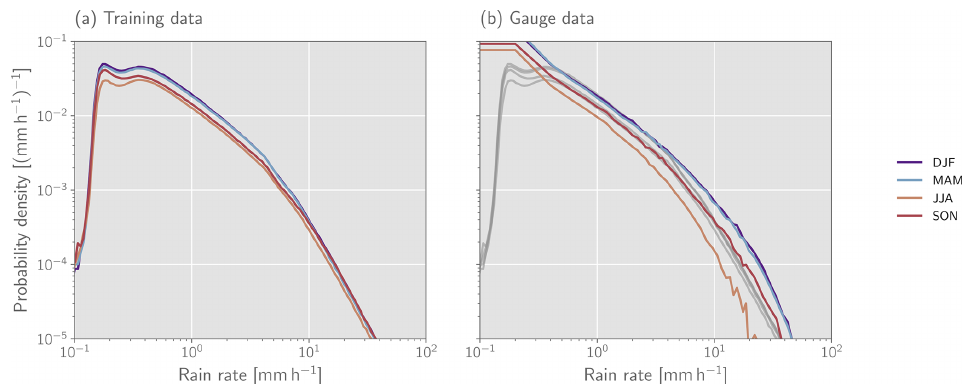
Figure 3. Distribution of reference precipitation rates. Panel (a) shows the seasonal PDFs of precipitation rates in the training data. Panel (b) shows the PDFs of precipitation rates measured by the gauges over the time period covered by the training data. Grey lines in the background trace the PDFs of the precipitation rates in the training data shown in panel (a)